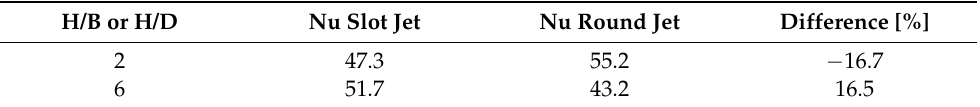
Figure 9. Nusselt trend comparison between slot and round jet, for H/B = H/D = 2 ( left ) and 6 ( right ). Table 3. Average Nusselt number comparison between round and slot jet with its percentage difference for different jet-wall distance.